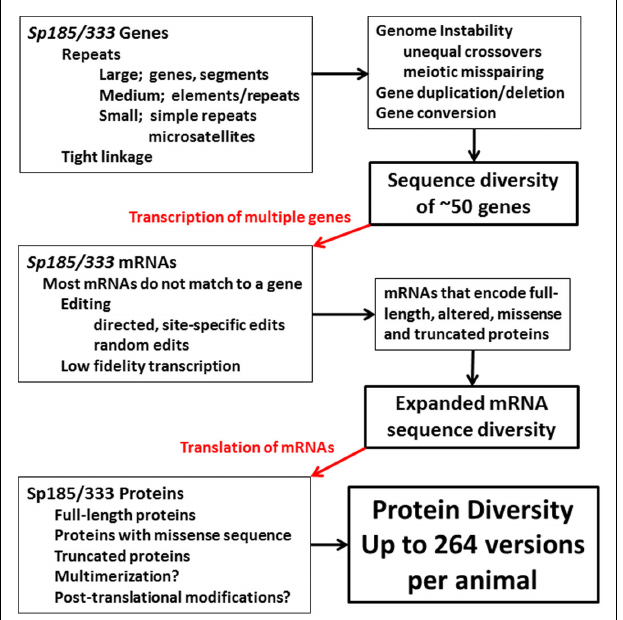
FIGURE 15 | Diversification in the Sp185/333 system in the purple sea urchin. Putative diversification mechanisms based on genomic instability may function to increase gene sequence diversity and may also vary the size of the gene family among individuals. mRNA sequence diversity imparted by the genes is expanded by editing some of the mRNAs in addition to possible low fidelity transcription.The mRNAs are translated to generate a broad array of proteins that may multimerize and be post-translationally modified.The end result is protein diversity that is much broader than what is encoded by the